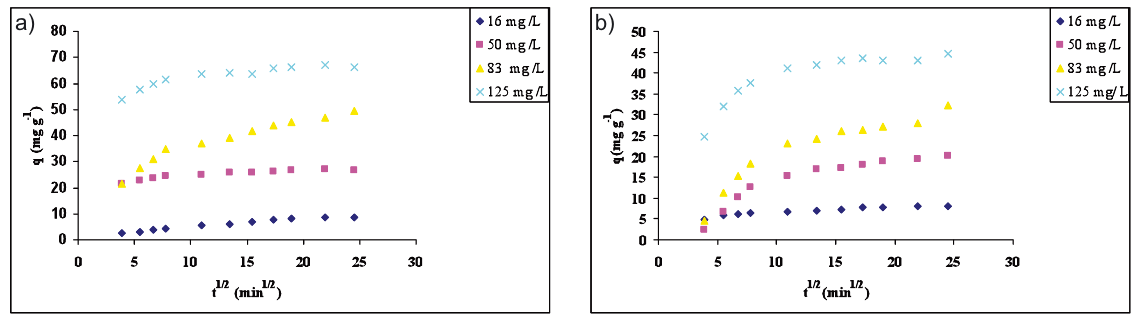
Figure 3. Intraparticle diffusion for Ag(I) sorption onto a) As 14P and b) As 15P (m=0.1 g resin, pH=4, T=25 o